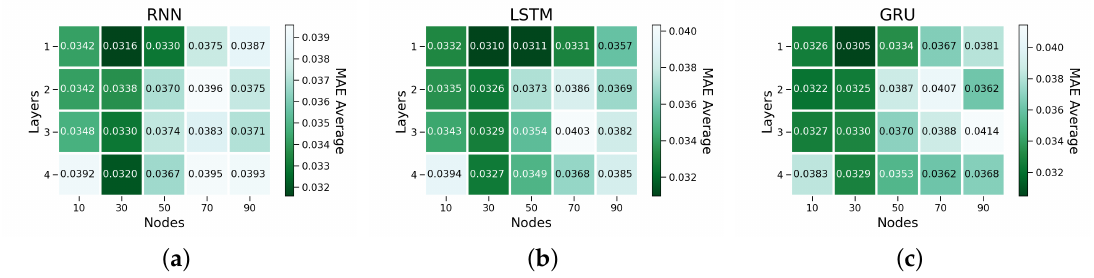
Figure 5. Mean absolute error (MAE) grid search result for ( a ) simple RNN, ( b ) LSTM, and ( c ) GRU.